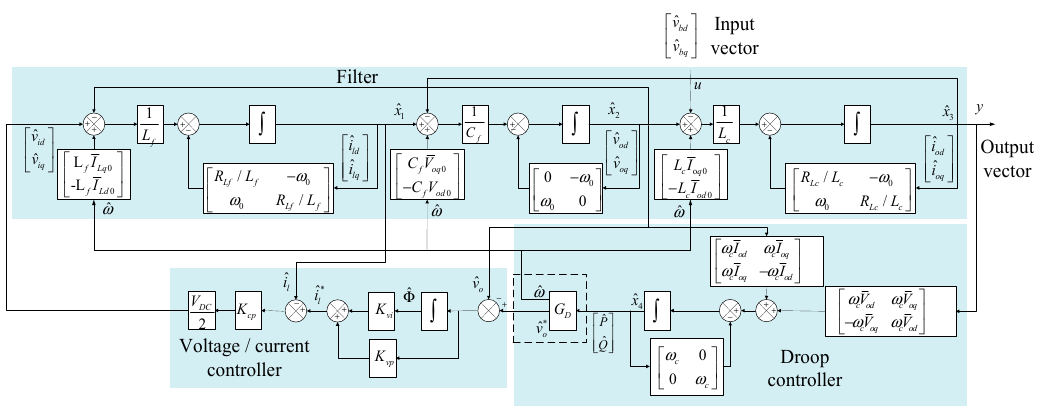
Figure 2. Analogue block diagram of a distributed generation (DG) unit and its controller.